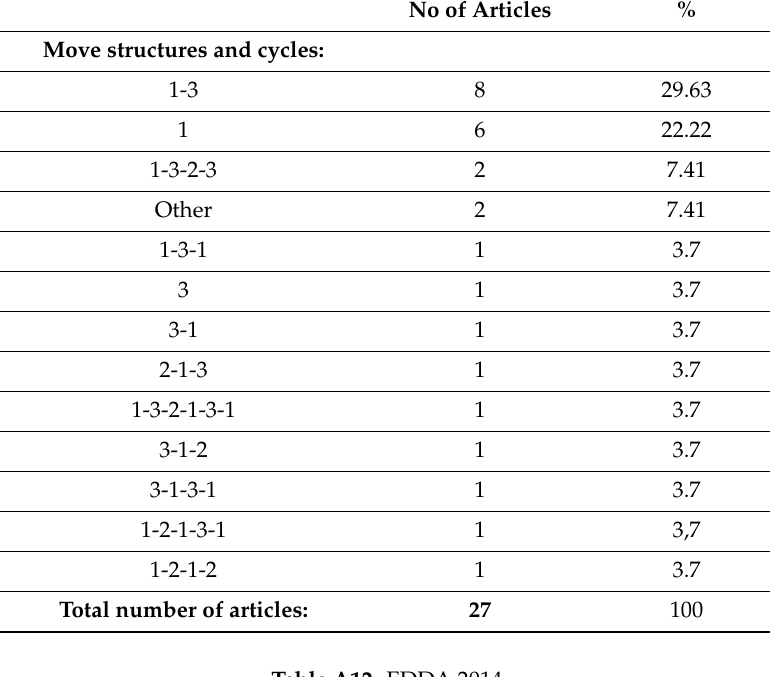
Table A11. EDDA 1994.